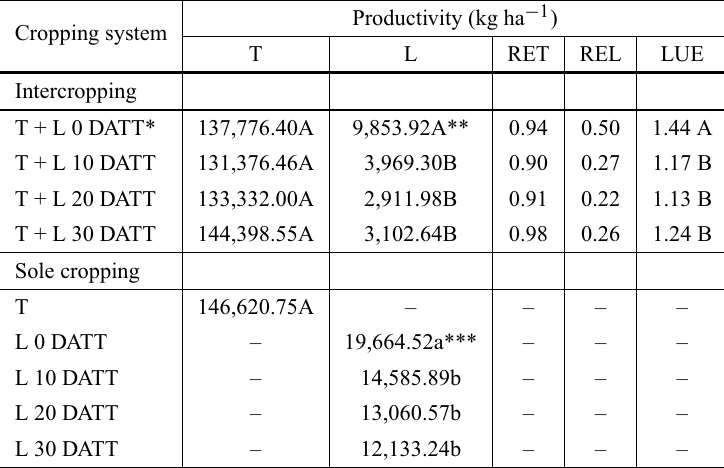
Productivity of tomato (T) and lettuce (L) in intercropping and in sole crop- ping; relative efficiency indices of the crop components of intercropping (RET and REL for tomato and lettuce, respectively) and land use efficiency index (LUE). Second cropping season: January 30 to July 25, 2004 Productivity (kg ha − 1 Cropping system